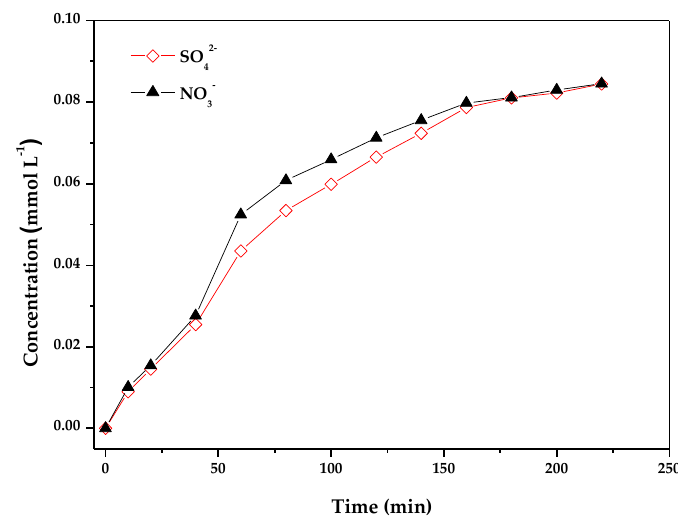
Figure 16. The concentration variation of NO 3 − and SO 42 − during photocatalytic degradation of methyl with ZnBiErO 4 as catalyst under visible light irradiation.